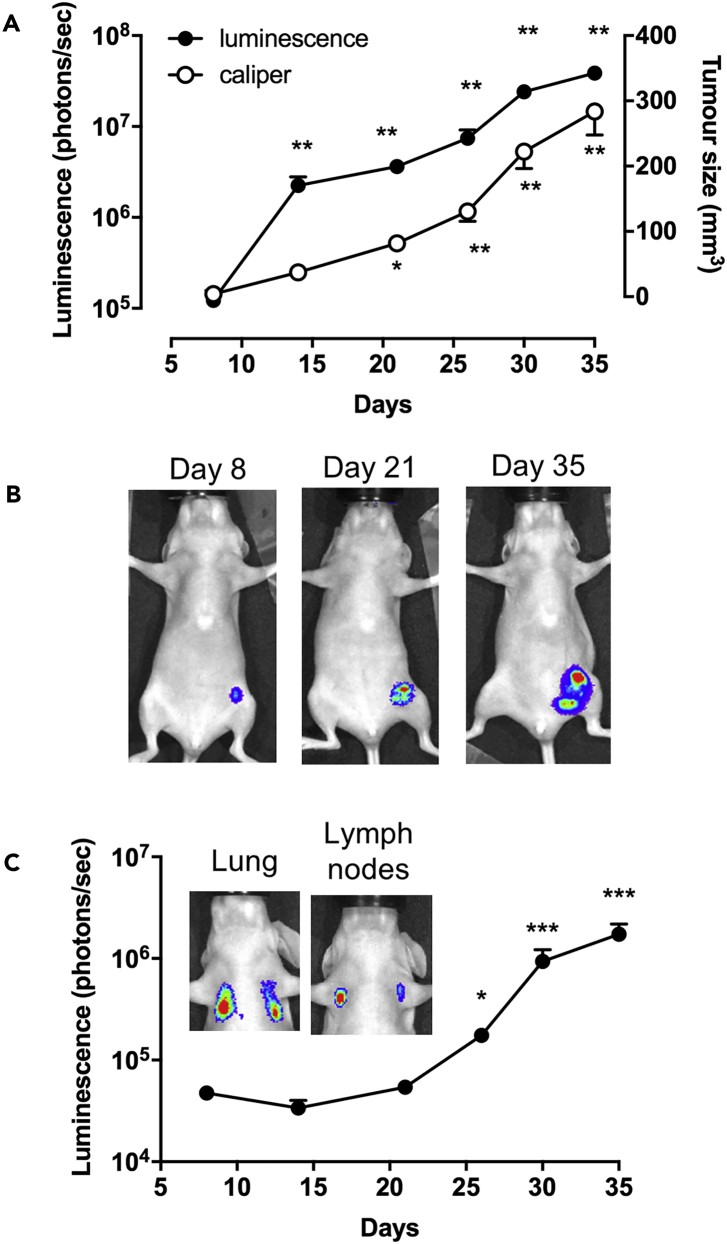
Whole-Animal Bioluminescence Imaging of NanoLuc-β2AR MDA-MB-231HM Tumor Growth and Metastasis Development(A) Female BALB/c nu/nu mice (7-week-old) were injected in the fourth left mammary fat pad with 5 × 105 MDA-MB-231HM triple-negative human breast cancer cells that stably express the NanoLuc-tagged human β2-adrenoceptor. Tumor development was monitored by bioluminescence imaging (left y axis) 5 min after IV injection of the NanoLuc substrate furimazine (100 μL in PBS, circa 0.37 mg/kg) or by caliper measurements (right y axis) over 35 days.(B) Representative bioluminescence images of primary tumors.(C) Bioluminescence monitoring of the development of metastasis in lungs and axillary lymph nodes. Inset: representative images of lung and lymph node metastasis. Data were obtained from 11 mice and are expressed as mean ± SE. *p < 0.05, **p < 0.005, ***p < 0.0001 (two-way ANOVA with Tukey's multiple comparisons with respect to day 8 baseline). For luminescence measurements, the statistical analysis was applied to the log transformed values.